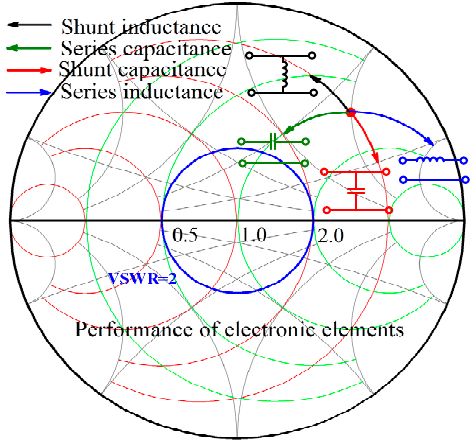
Figure 3. Performance of electronic elements on a Smith chart.